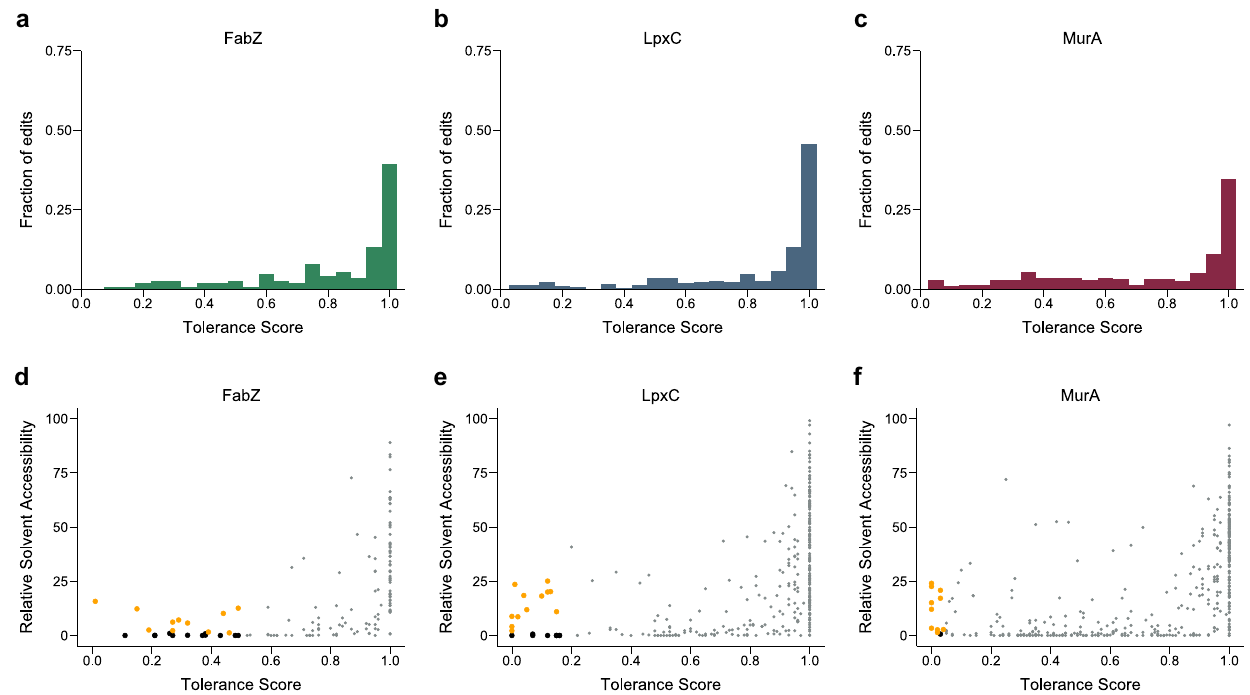
Fig.5|Analysisofthenumberandtypesofaminoacidsubstitutionspresentat each position of the saturation editing libraries can be used to identify important residues. The distribution of tolerance scores, i.e. how tolerant each residue is towards substitutions with different amino acids, is shown for FabZ ( a ), LpxC ( b ) and MurA ( c ). The relative solvent accessibility (RSA) is plotted in function of the tolerance score for each residue of FabZ ( d ), LpxC